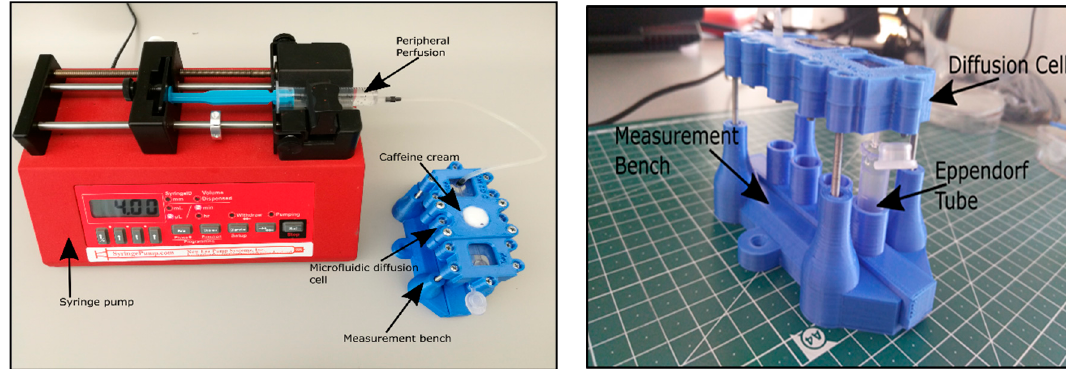
Figure 3. The performance of a microfluidic diffusion chamber (MDC) experiment. Left: The set-up of the microfluidic system with a syringe pump and the chip. Right: The position of the sample collection vial in the 3D printed measurement bench of the microfluidic device.